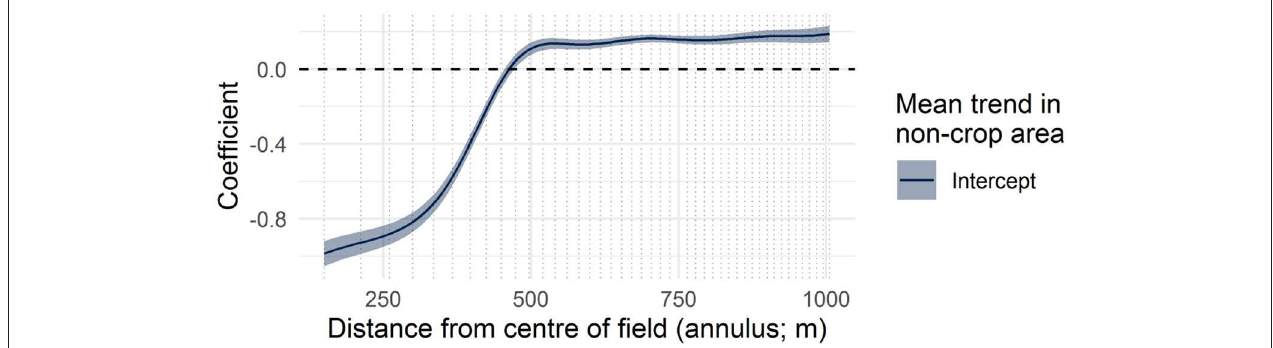
FIGURE 3 | The model intercept function (or mean landscape complexity curve) shown with two standard errors. The curve represents the estimated effect on the proportion of non-crop area and how it varies over distance from the center of an average field. Vertical dotted lines in this and subsequent figures indicate annulus radii at which fields were measured, providing support for the